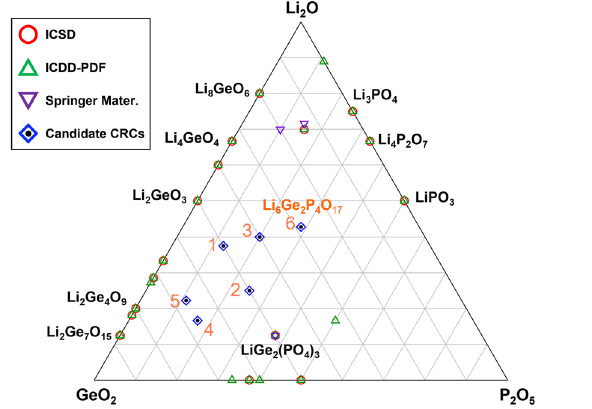
Fig. 3 Candidate CRCs on the Li 2 O-GeO 2 -P 2 O 5 pseudo-ternary system with chemical compositions registered in three databases, i.e., ICSD, ICDD-PDF, and SpMat. Adopted from ref. 19 with small modi fi cations.